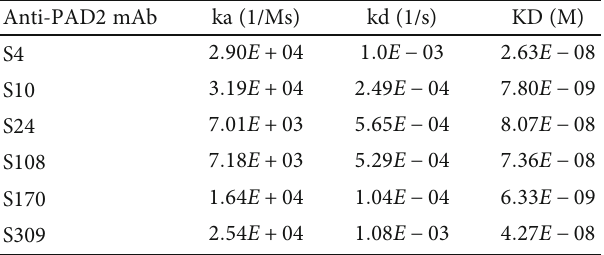
Figure 2: Crossreactivity of chimeric anti-PAD2 antibodies with recombinant mouse PAD2. The values in the bracket indicates EC of antibodies against rhPAD2 and rmPAD2 enzymes. The enzyme-linked immunosorbent assay protocol is described in Materials and Methods. Table 1: Kinetics of binding of chimeric anti-PAD2 monoclonal antibodies (mAbs) with recombinant human